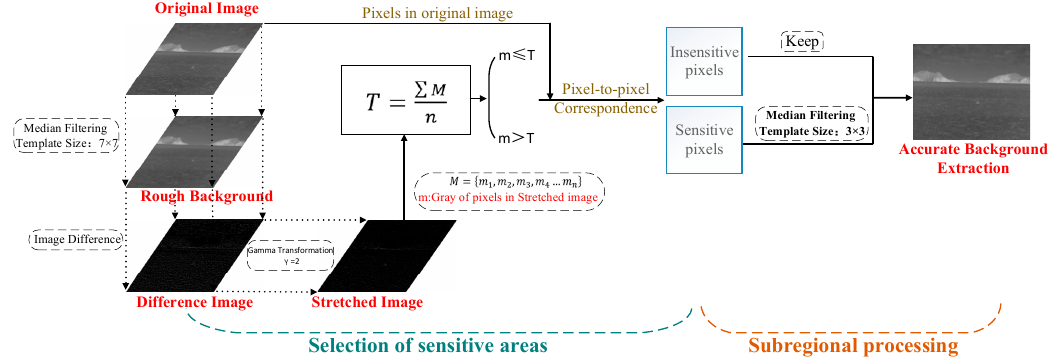
Figure 9. Flow chart of the proposed median filter based on sensitive area acquisition .